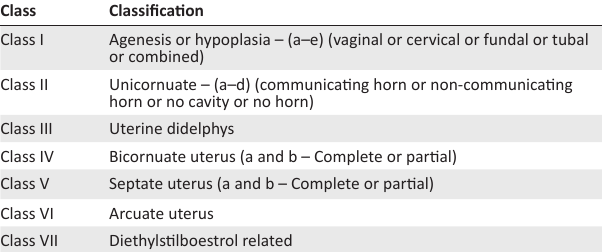
FIGURE 3: (a) Coronal T2 sequence demonstrates a complete septate uterus with a myoma (star) in the septum. (b) Sagittal T2 sequence shows a Gartner’s duct cyst with focal sacculations (double-headed white arrow) from the fornix extending along the anterior vaginal wall, well delineated against the instilled gel in the vagina. (c and d) Axial T1 sequence demonstrates a left ureterocoele with a blind-ending atretic ureter (white arrows) in the broad ligament. (e) Coronal T2 sequence shows a normal right kidney; left kidney not visualised. (f) Incidental left adrenal adenoma (fat component in out-of-phase images) marked by a white arrow. TABLE 1: American Society for Reproductive Medicine